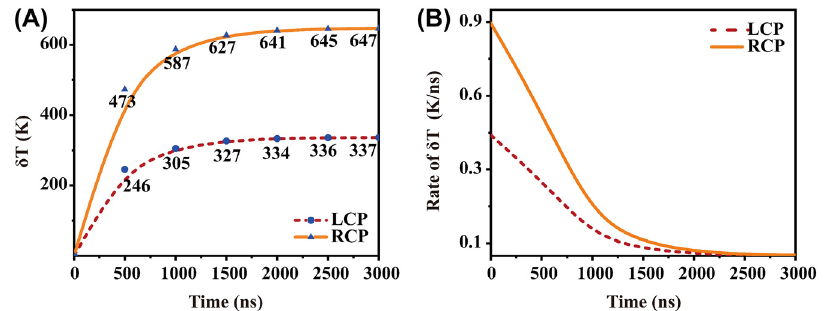
Figure 4: Dynamics of average temperature increases of the LCN with time evolution.